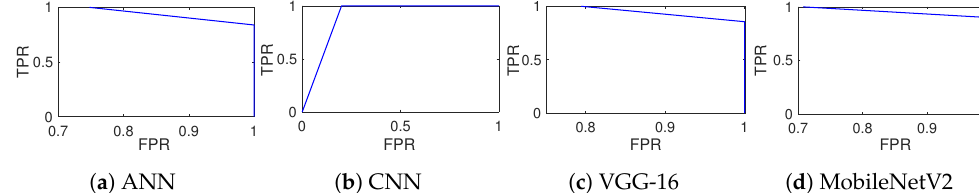
Figure 13. Models accuracy on Soft rot disease classification.